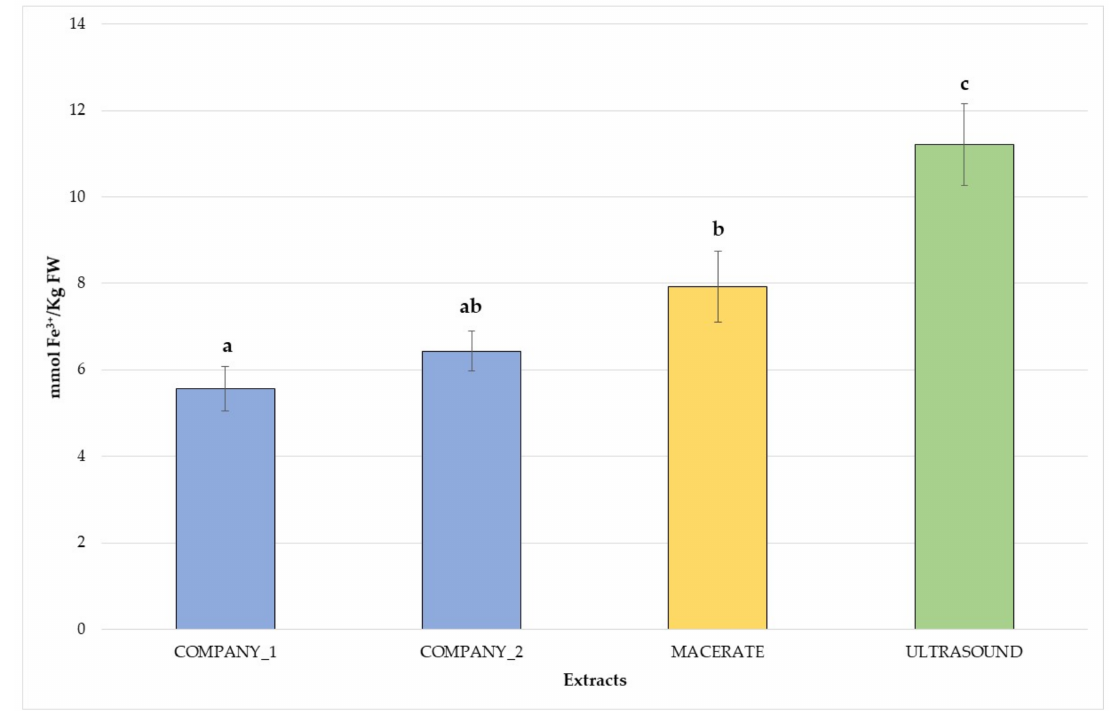
Figure 2. Antioxidant capacity of the analysed V. vinifera bud-extracts. Different letters for each extract highlight the significant differences at p < 0.05; blue—commercial bud-preparations, C1 and C2; yellow—traditional macerate, M; green—ultrasound extract,